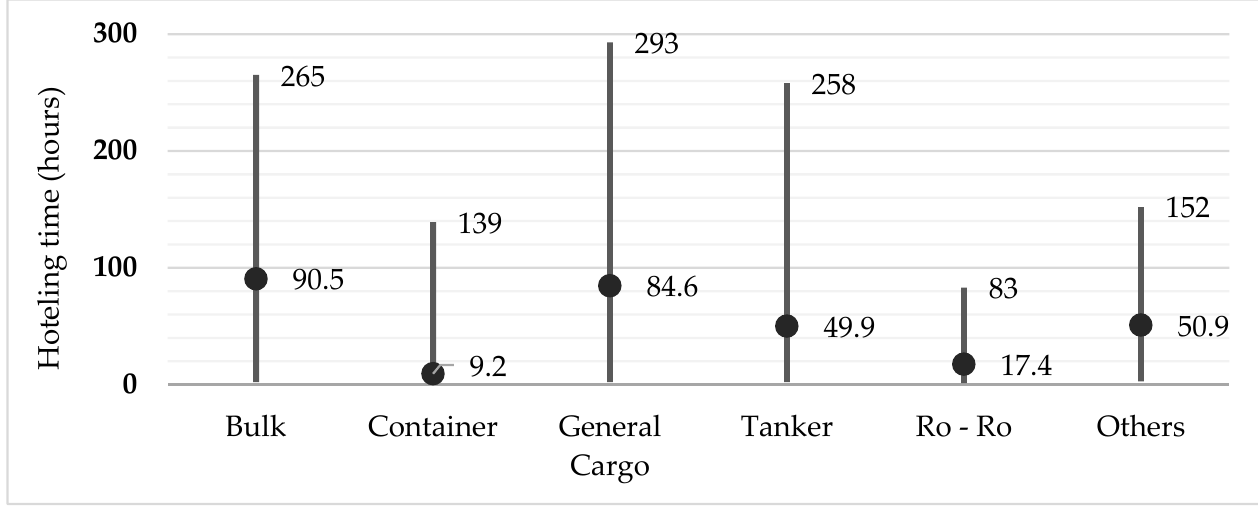
Figure 4. Hoteling time by ship type.